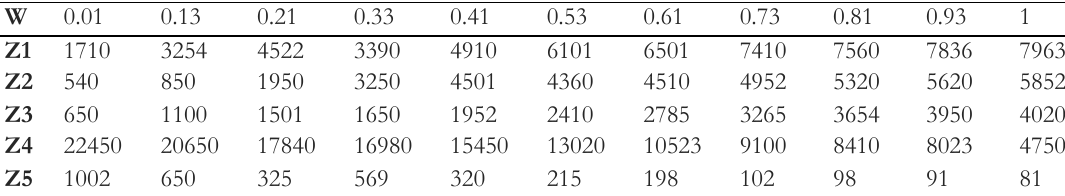
Table 3. The values of objective functions with LP metrics.